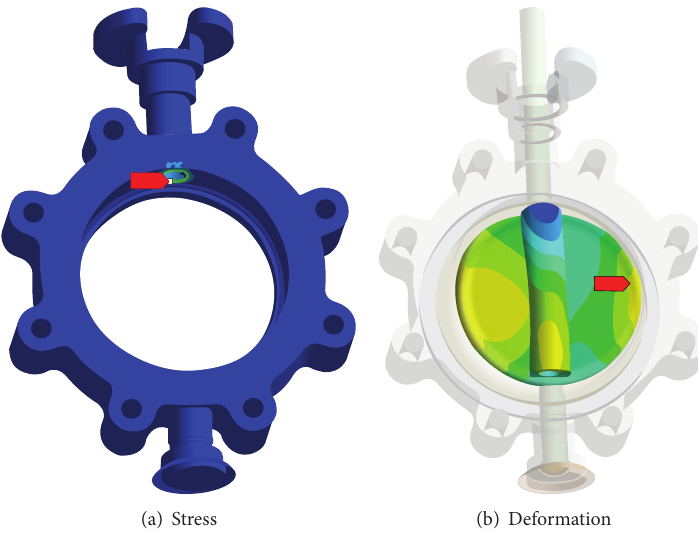
Figure 7: Results of structural analysis under reverse pressure according to Grade D of the KEPIC MFA.